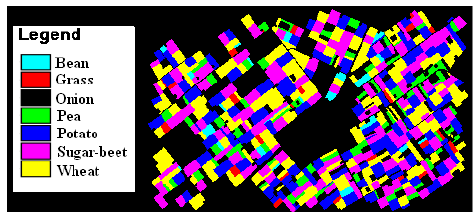
Figure 2. Land cover map of study area